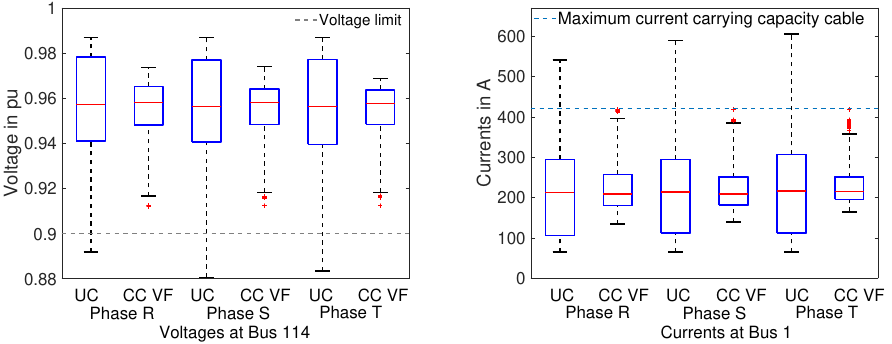
Figure 11. Comparison of phase voltages and currents for UC and CC VF.